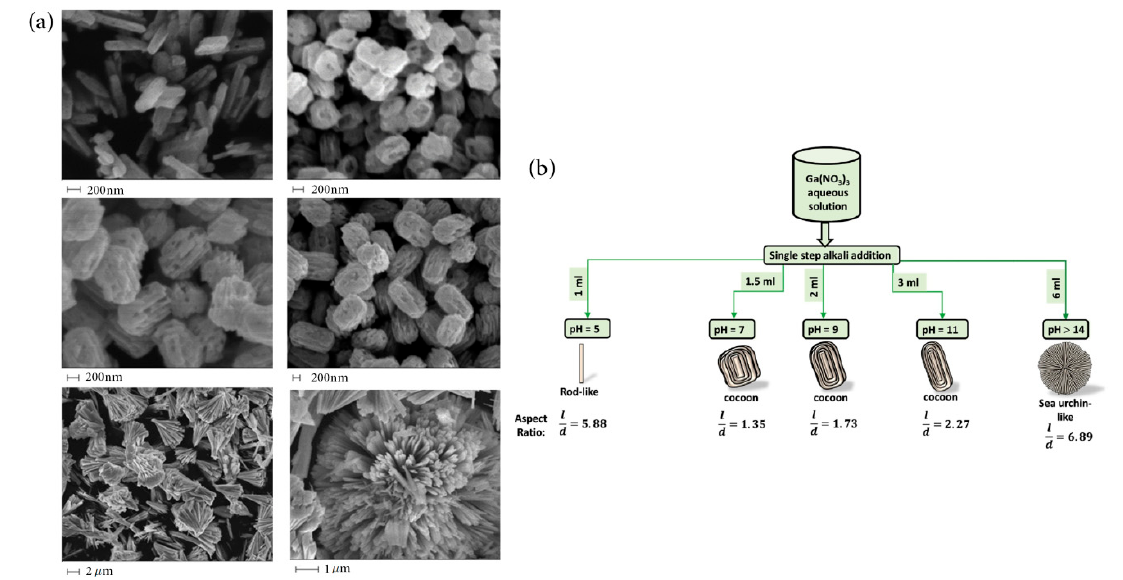
Figure 7. ( a ) SEM images of the morphological evolution of β‐ Ga 2 O 3 nanostructures [159]. ( b ) Schematic representation of morphological evolutions at different pH values [159]. Copyright 2020 Elsevier.